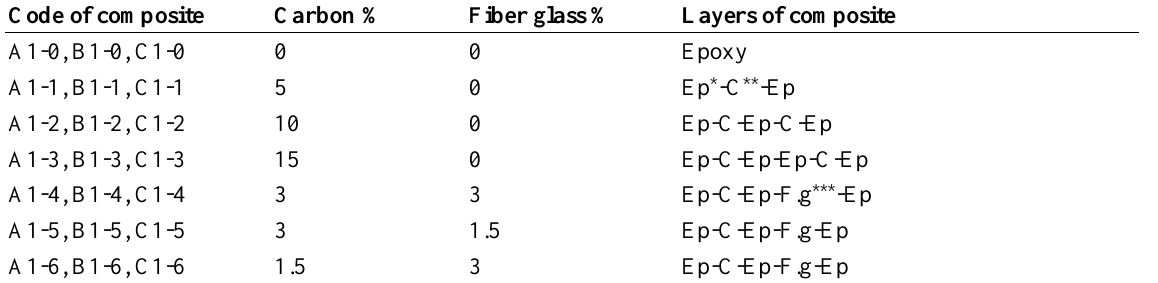
Table 4, Labeling each specimen for the mechanical tests Code of composite Carbon % Fiber glass % Layers of composite